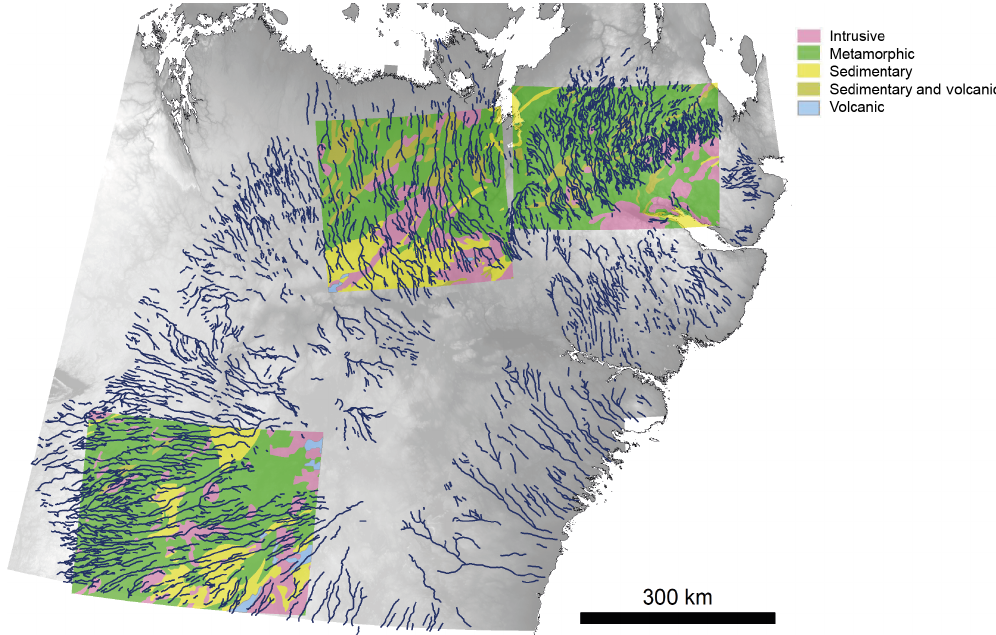
Figure A3. Bed geology across the three test sites (left–right) used for analysis in Sect.